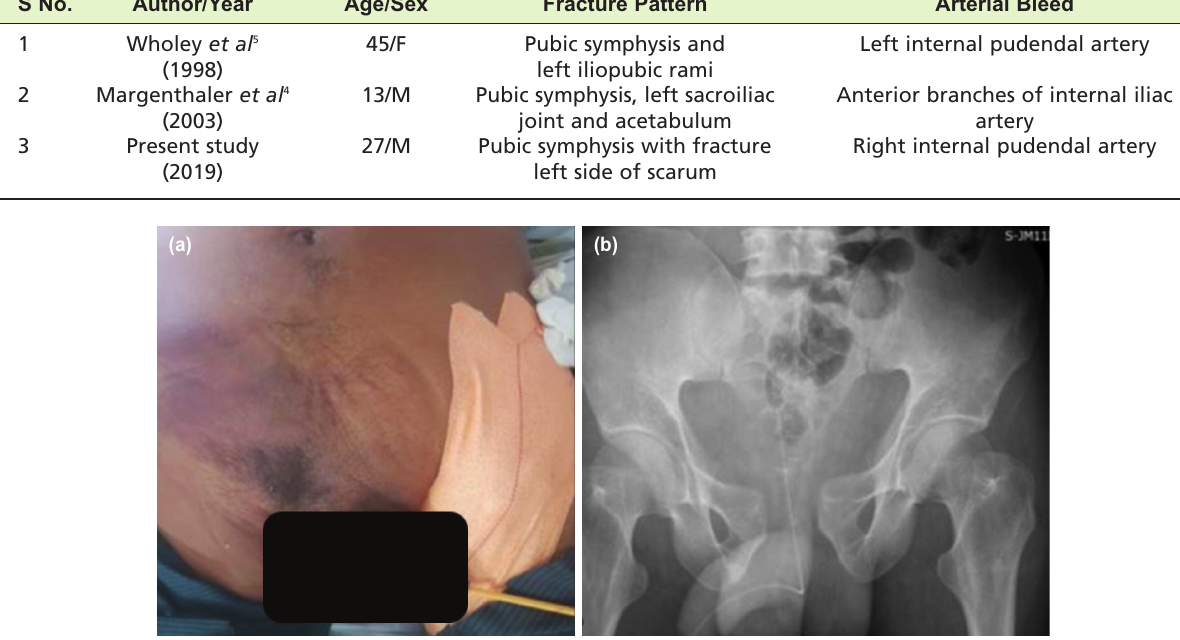
(a) Clinical image showing bruising involving right lower anterior abdominal wall with extension into scrotal sac. (b) Radiograph Fig. 1: of pelvis reveals “open-book” pelvic injury with fracture of the left side of the sacrum.